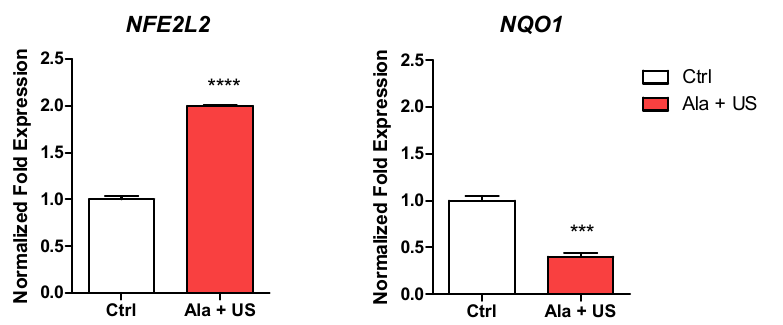
Figure 5. NFE2L2 and NQO1 mRNA expression after SDT. Control and experimental groups were either treated with a saline iv injection into the tail vein (0.5 mL), an Ala iv injection into the tail vein (375 mg/kg bw), US alone (1.5 W cm 2 , 1.8 MHz, 300 s), or Ala and US (1.5 W cm 2 , 1.8 MHz for 300 s, at 4 h after the Ala 375 mg/kg bw iv injection, SDT group). NFE2L2 and NQO1 mRNA expression was determined by real-time RT-PCR at 72 h after SDT. RRN18S was used as a reference gene to normalize the data (mRNA levels were compared with those of the control group, which are stated as 1). Statistically significance vs. untreated tissue (Ctrl): *** p ≤ 0.001, **** p ≤